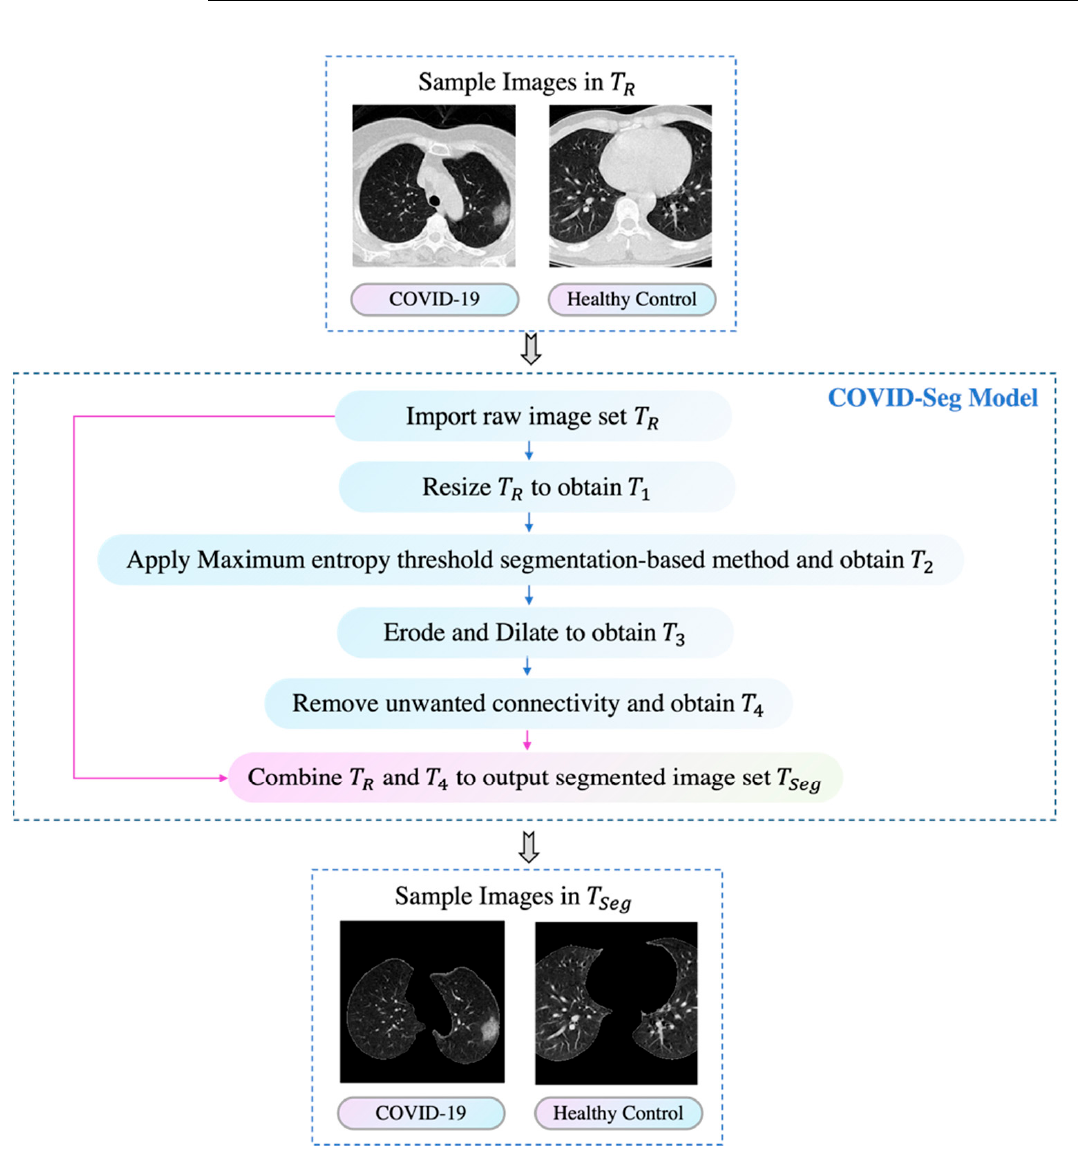
Figure 3. General process of COVID-Seg model.